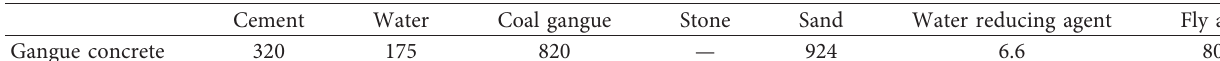
Table 4: Coal gangue concrete mix proportion (kg/m 3 ).